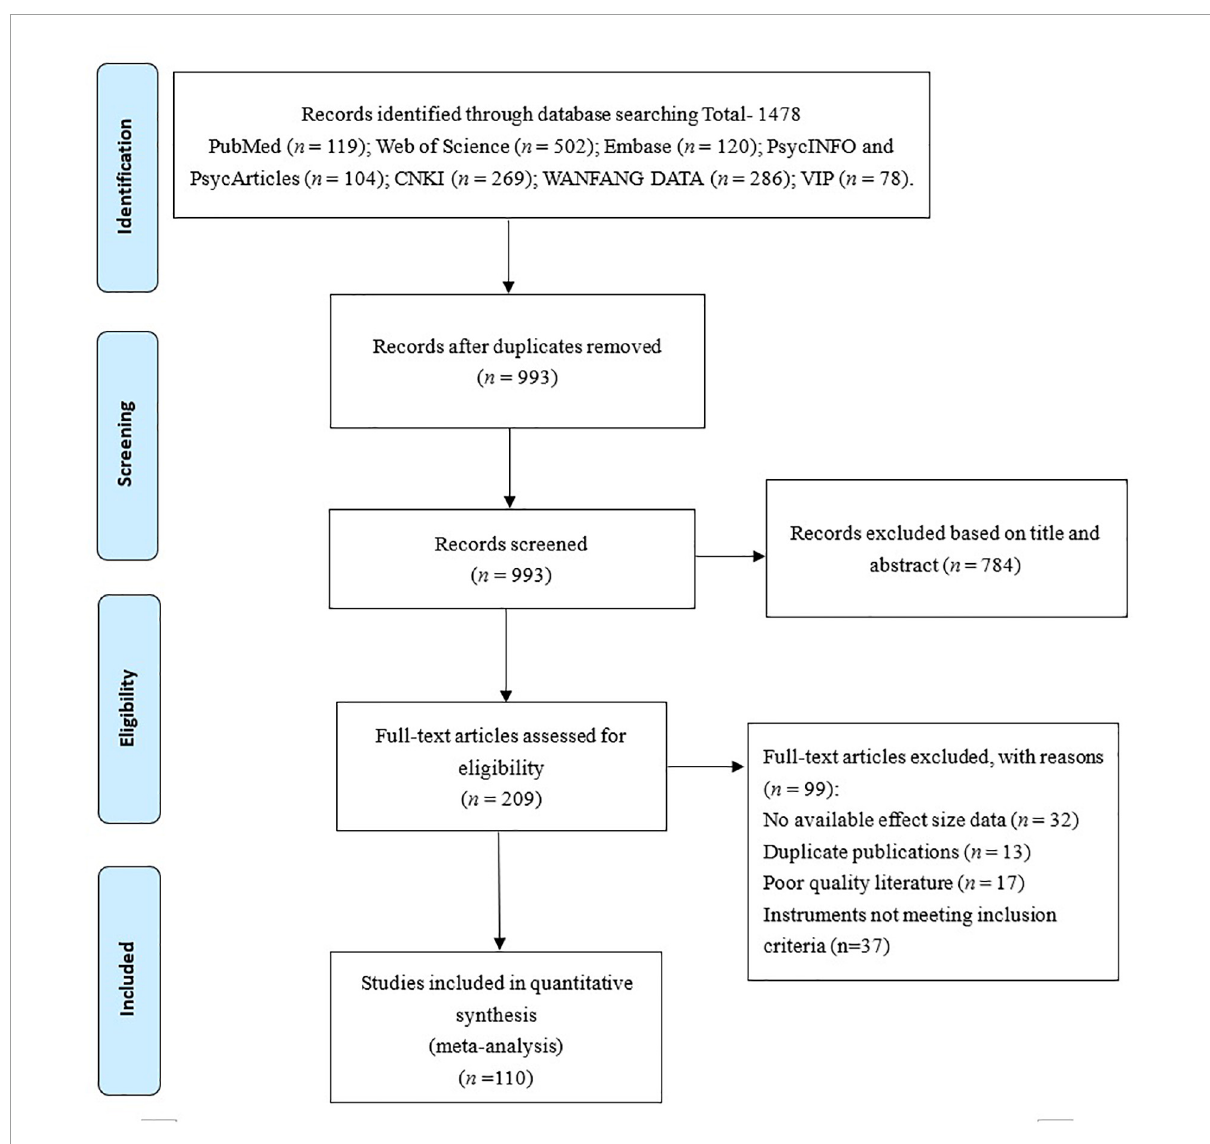
FIGURE1 The flow chart of the study selection